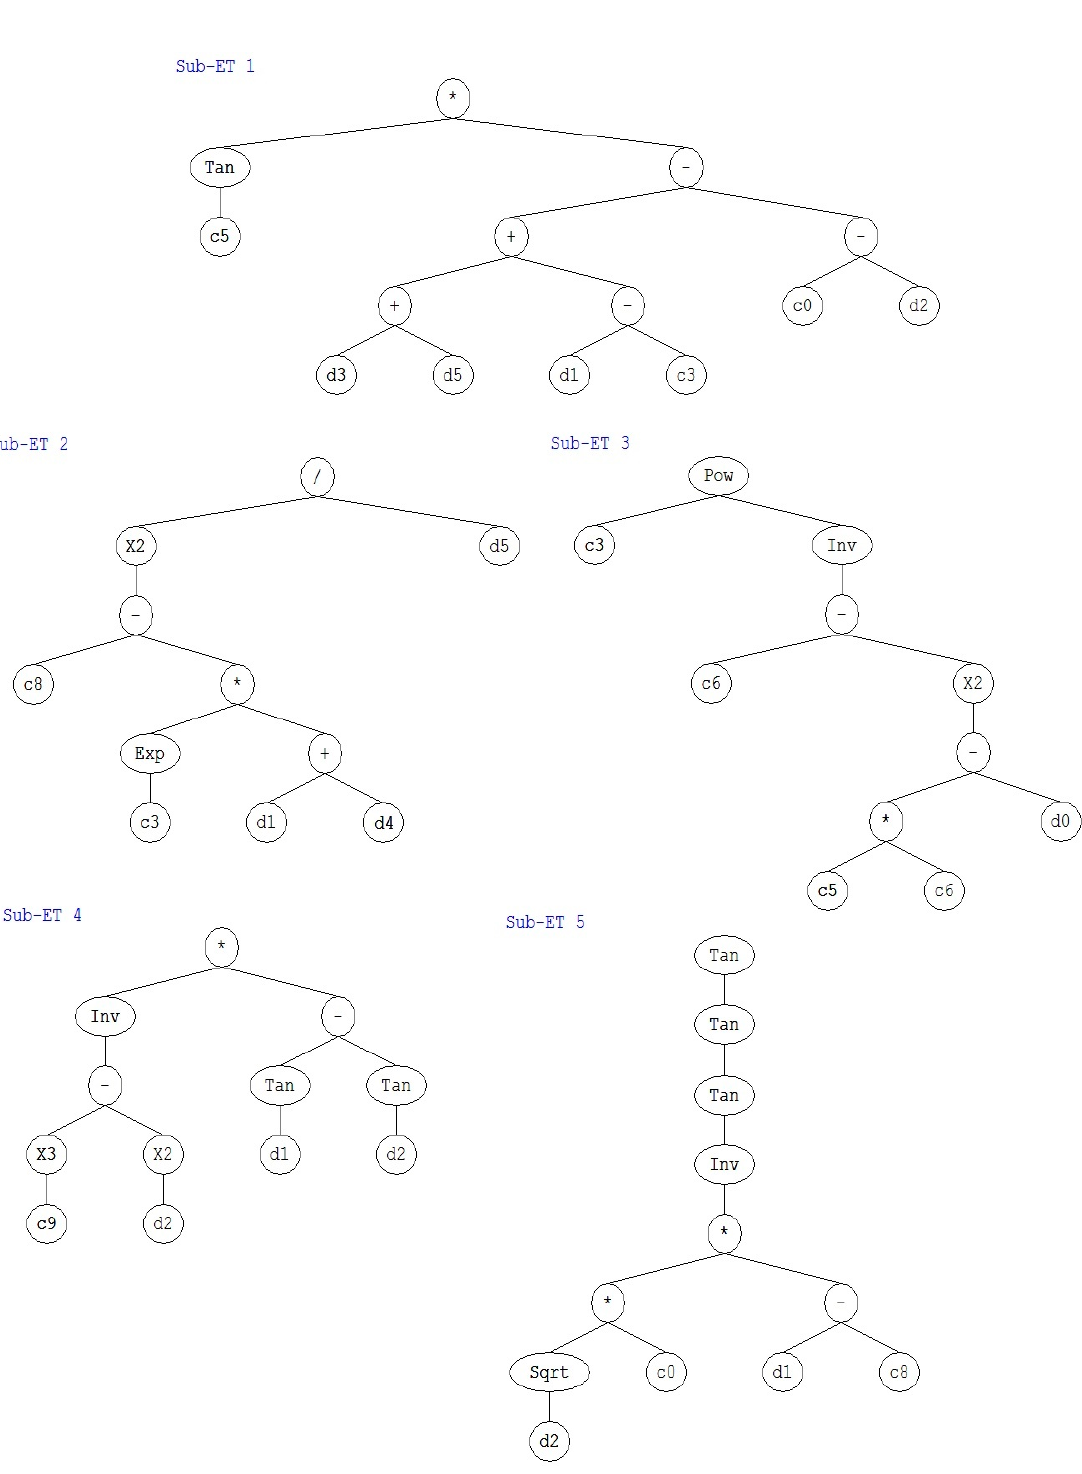
Figure 20. Expression tree for convergence prediction.